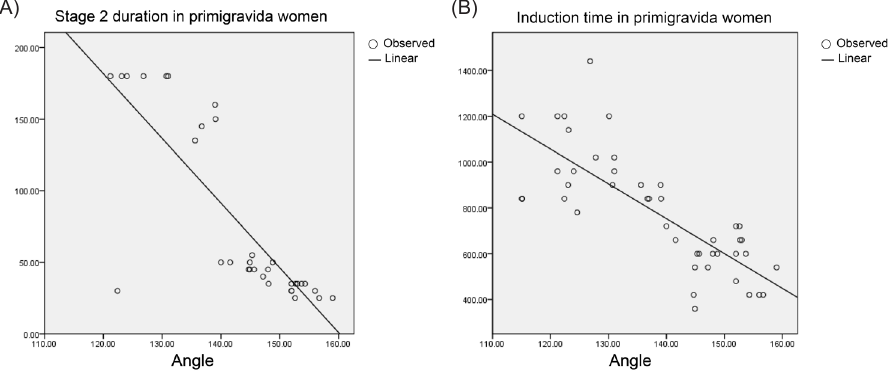
Figure 3. ( A) Correlation between angle of progression and stage 2 duration in primigravida women. (B) Correlation between angle of progression and stage 2 duration in primigravida women.